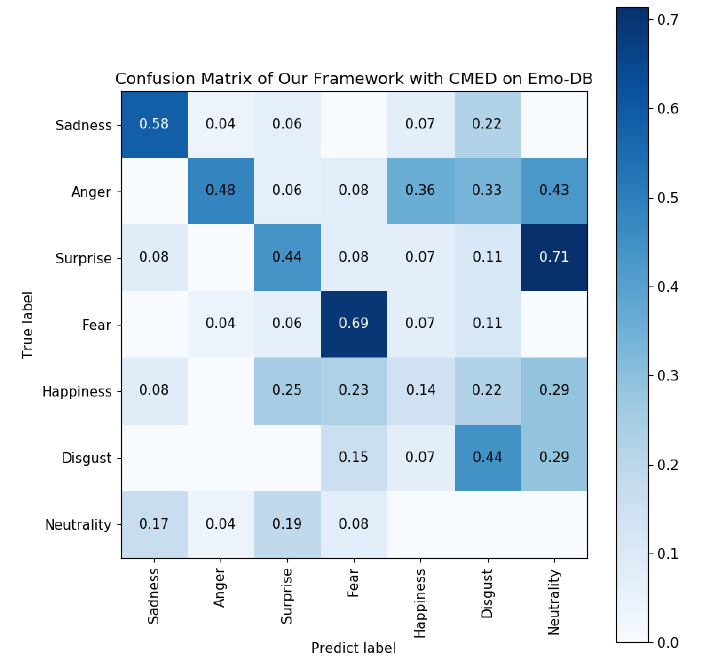
Figure 13. Confusion matrix of our framework with CMED on EMO-DB.